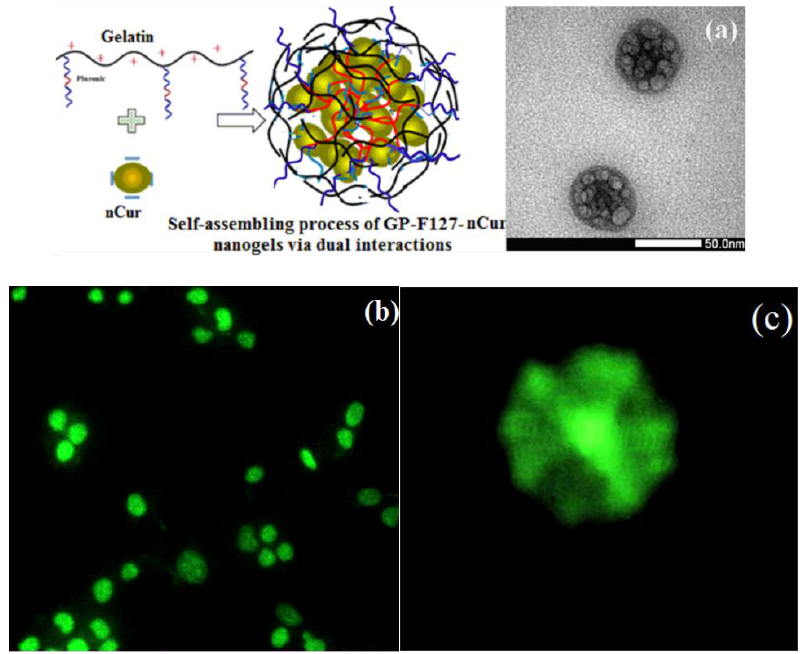
Figure 7. Demonstrating self assembling process of GP-F127 and nCur via dual interactions ( a ), Andor Dragonfly confocal microscope of GP-F127-nCur under 100× objective ( b )( c ).